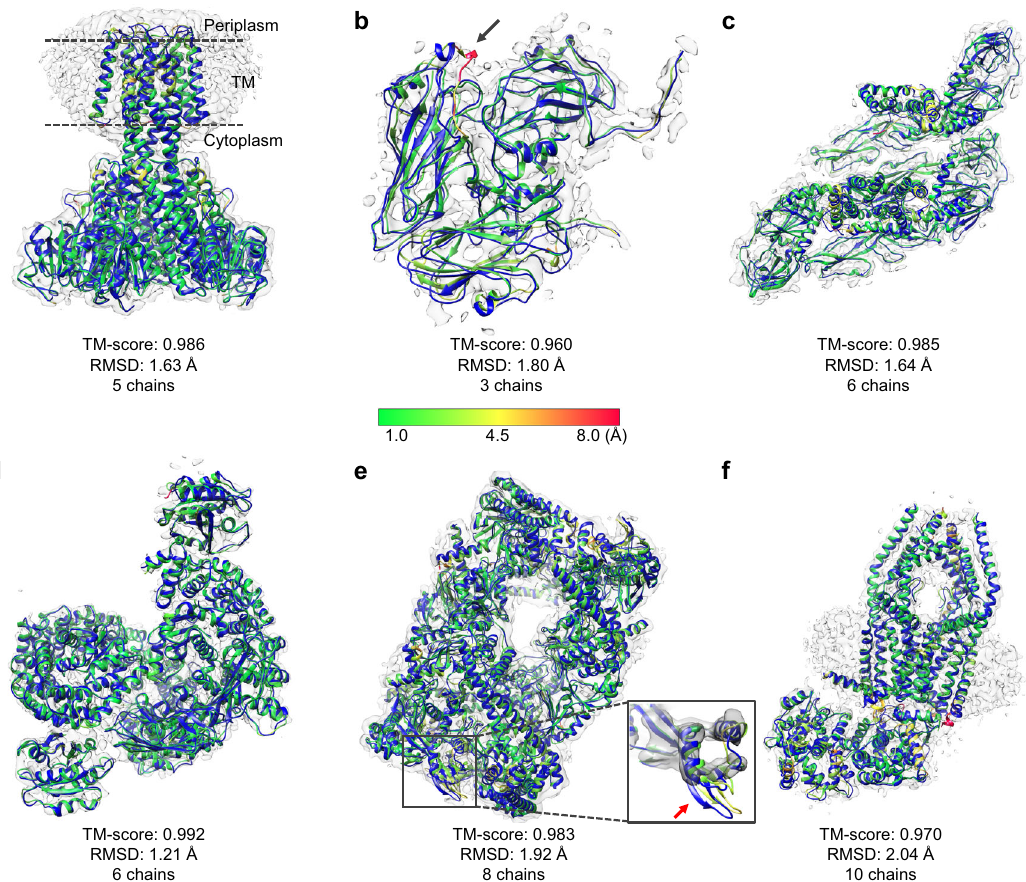
Fig. 4 Examples of the protein complex structures built by EMBuild on single-particle cryo-EM maps. The reference PDB structures are colored in blue and the corresponding EM density maps are colored in transparent gray. The built structures by EMBuild are colored from green to red according to C α displacements with respect to the reference structure. a EMD-3605 at 4.2 Å resolution (PDB ID: 5N9Y). b EMD-3856 at 5.2 Å resolution (PDB ID: 5OWX). A poorly modeled loop is indicated by an arrow. c EMD-6685 at 4.3 Å resolution (PDB ID: 5WSN). d EMD-7453 at 4.3 Å resolution (PDB ID: 6D83). The enlarged view displays the EM density volume around a poorly modeled region (indicated by red arrow). e EMD-9317 at 5.2 Å resolution (PDB ID: 6N1Q). f EMD-22216 at 4.6 Å resolution (PDB ID: